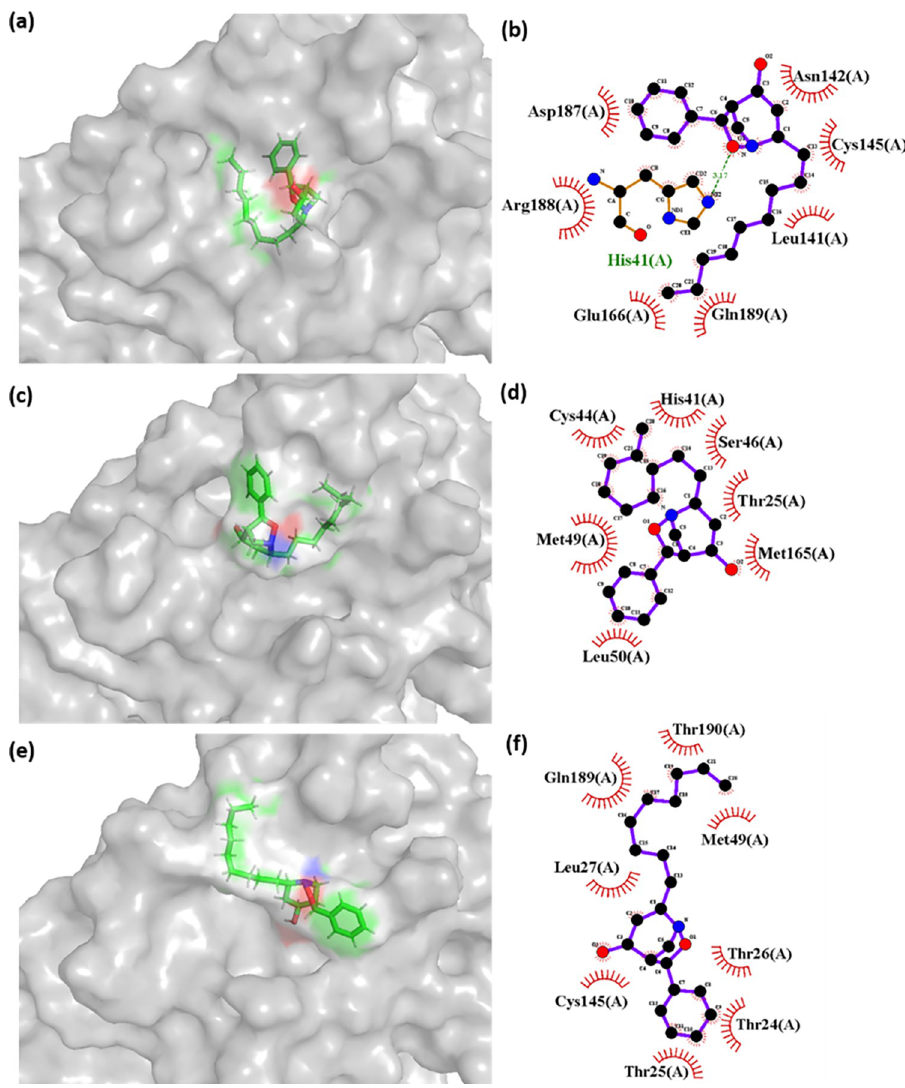
Fig 11. 3D and 2D interaction plot of CMP2 (NET5) with the 3CL protease protein at (a-b) 0 ns (c-d) 50 ns, and (e-f) 90 ns of the simulation trajectory. 2D interaction map was formed using